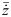
Flow chart of the experimental procedure.Structures are manufactured using the laser cutter. Structures are dropped and recorded J = 5 times. The dominant falling behaviour is extracted across these trials. The measured outputs are extracted and average over these trials, yielding z˙¯ and γ¯˙. The process is repeated for every combination of l and θ in the search space.